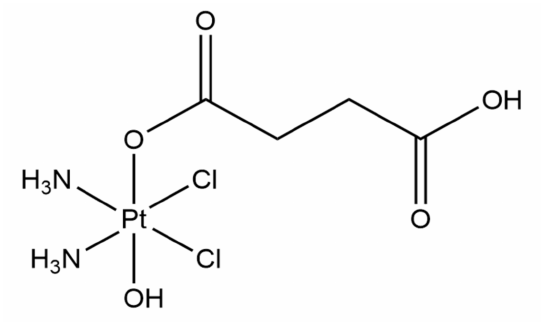
Figure 2. Chemical structure of Compound 1